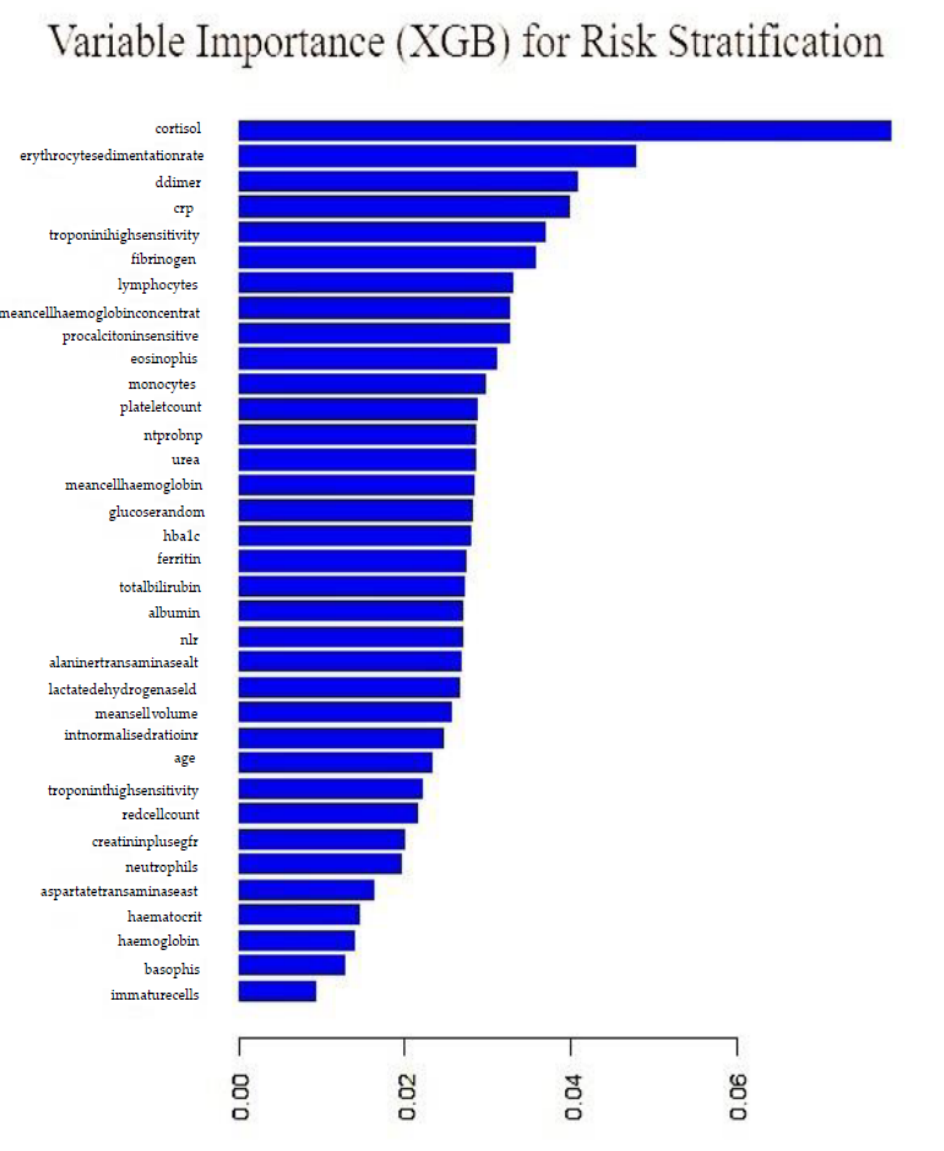
Figure 18. Variable importance from extreme gradient boosting